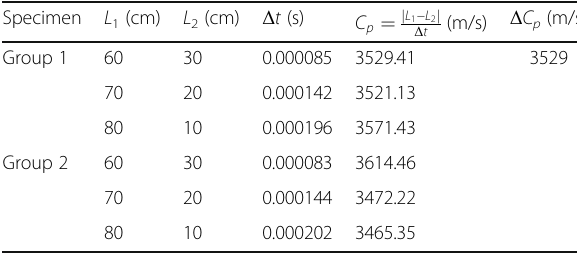
Table 2 Theoretical ultimate load and applied load when visible crack occurs for each specimen Specimen L 1 (cm) L 2 (cm) Δ t